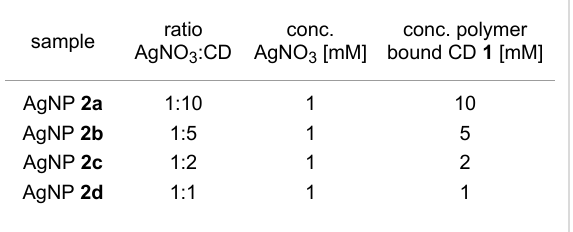
Table 2: Experimental conditions of the AgNP’s 2